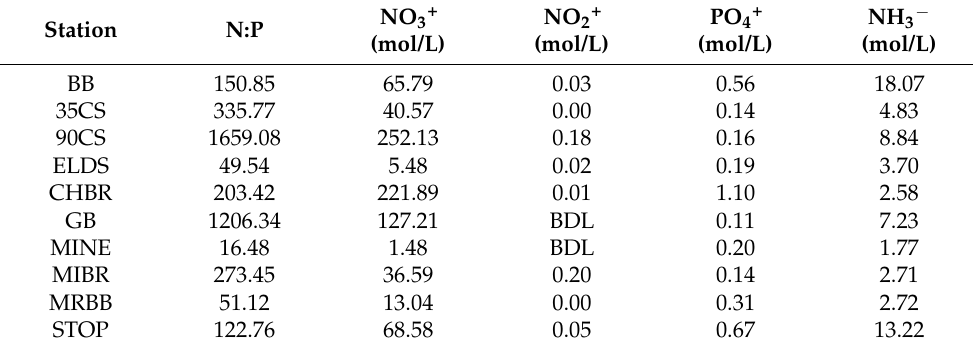
Table 3. Dissolved inorganic nutrient data including nitrogen.